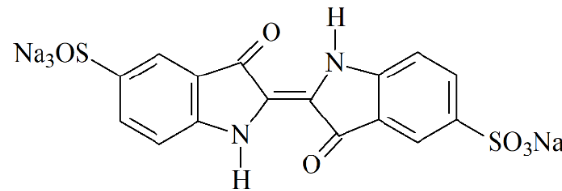
Figure 1. Indigo carmine structure.